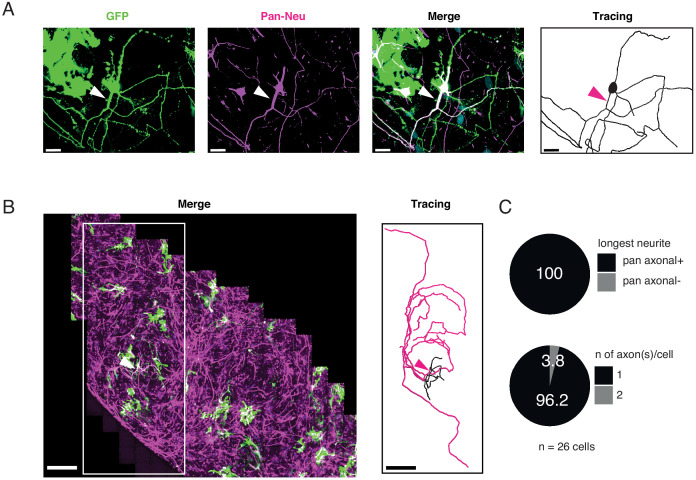
Characterization of axons in iNs.iNs were lipofected with a plasmid-expressing cytosolic GFP (GFP, green), fixed at d35, and stained with an axonal marker (Pan-Neu, magenta). (A) Chimpanzee iN stained with a pan-neurofilament antibody. The corresponding Imaris tracing is on the right. The arrowheads indicate that the longest of the neurites -as judged by the complete tracing in Imaris- is also positive for axonal marker (white arrowhead). Scale bar is 30 µm. (B) Low-magnification maximum-intensity projection of GFP-labeled cells (green) stained with pan-neurofilament antibody (magenta). The Imaris tracing on the right corresponds to the white box. Magenta tracing corresponds to the longest neurite. Of note, ape and human iNs generate long axons, compared to dendrites. As the longest neurite (axon) encompasses a large part of the total neurite length. Scale bar is 300 µm. (C) Quantifications show that (1) for 100% of the stained cells, the longest neurite is positive for axonal marker (upper pie chart) and (2) the majority of the cell (96% of total) features one axon. 4% of the cells were found to have two axons (bottom pie chart). Of note, in our system the % of cells with two axons is lower than what reported for iNs autaptic culture (Rhee et al., 2019). This is possibly due to the NGN2-iNs system in conjunction with the culture conditions.